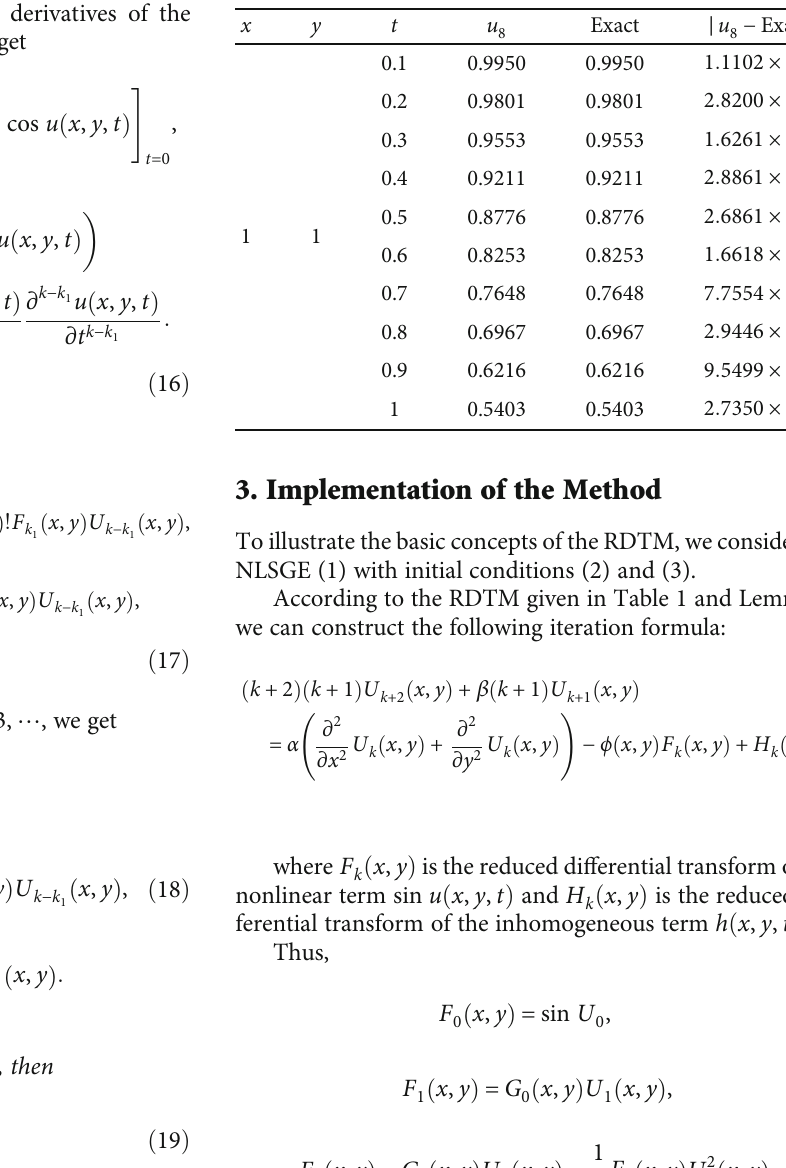
Table 2: Eighth-order approximate solution by RDTM of Example 1 for di ff erent values of t and comparison with the exact